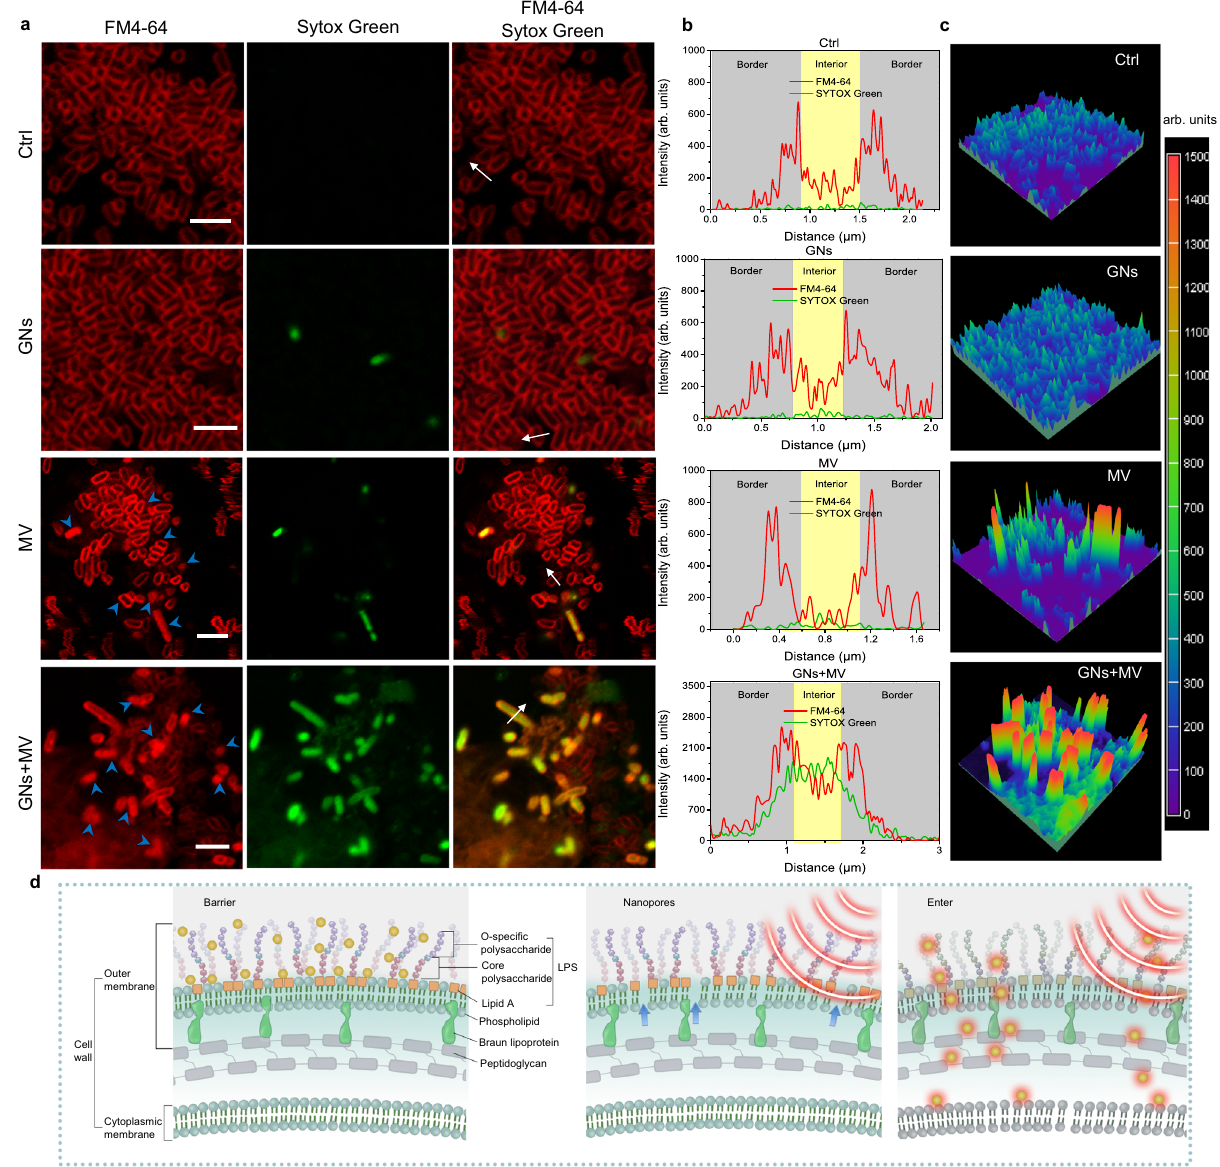
Fig. 6 Mechanism of GNs collaboration with MV to kill E. coli . a Fluorescent localization of the interactions between GNs, MV, and E. coli . The fl uorescent dyes FM4-64 to stain the OM (red), and SYTOX Green to show membrane permeabilization (green). Scale bar, 5 μ m. b Fluorescence intensity along the white arrows in a . c Intensity surface plot of different groups in a . d Schematic diagram of MV and GNs synergistically killing bacteria. GNs are represented by yellow spheres. Source data are provided as a Source Data fi